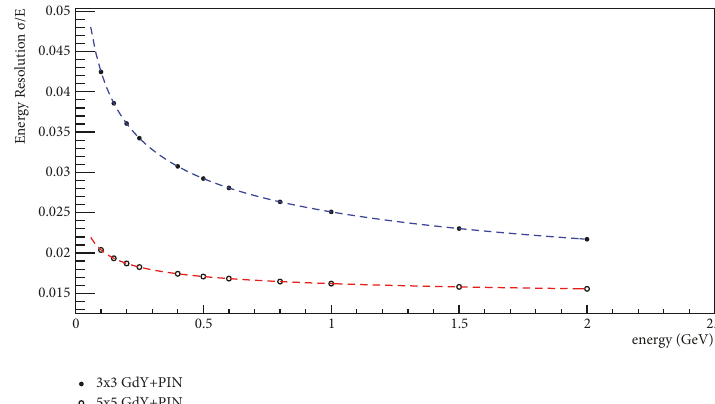
Figure 9: Parameterized energy resolution function for GdY as 3x3 and 5x5 matrices. Each scintillator has 27 cm thickness and back face area of 25 mm × 25 mm.